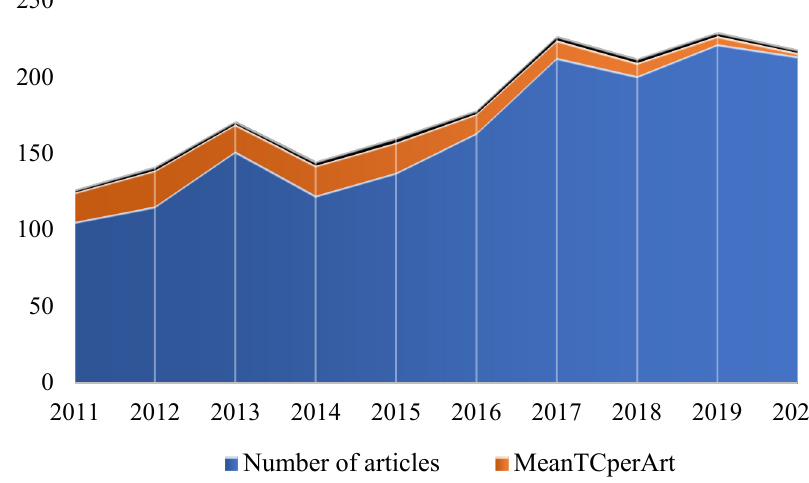
Figure 2. Annual scientific production on amaranths from 2011 to 2020.